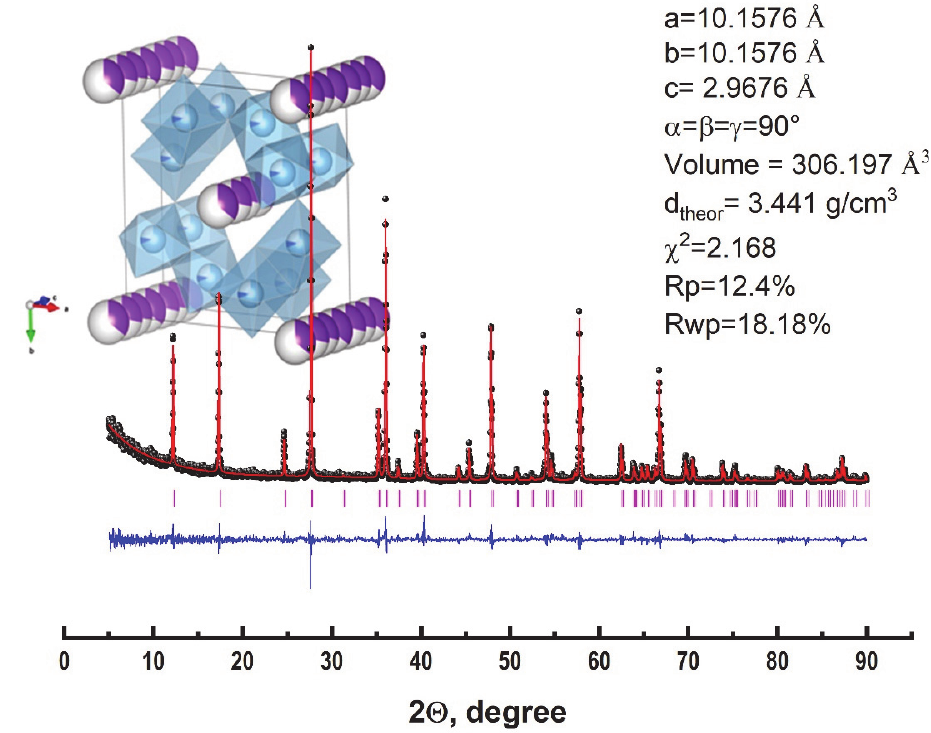
Figure 2. Combined X-ray diffraction patterns and Rietveld refinement of KFTO(H): black circles—experimental data, red line—calculated line, blue line—difference, purple vertical lines—Bragg positions.